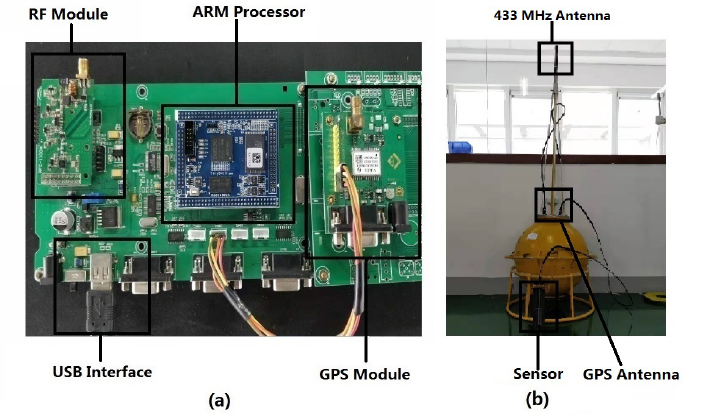
Figure 5. The sensor node in buoy. ( a ) The hardware structure of sensor node. ( b ) The maritime communication buoy.